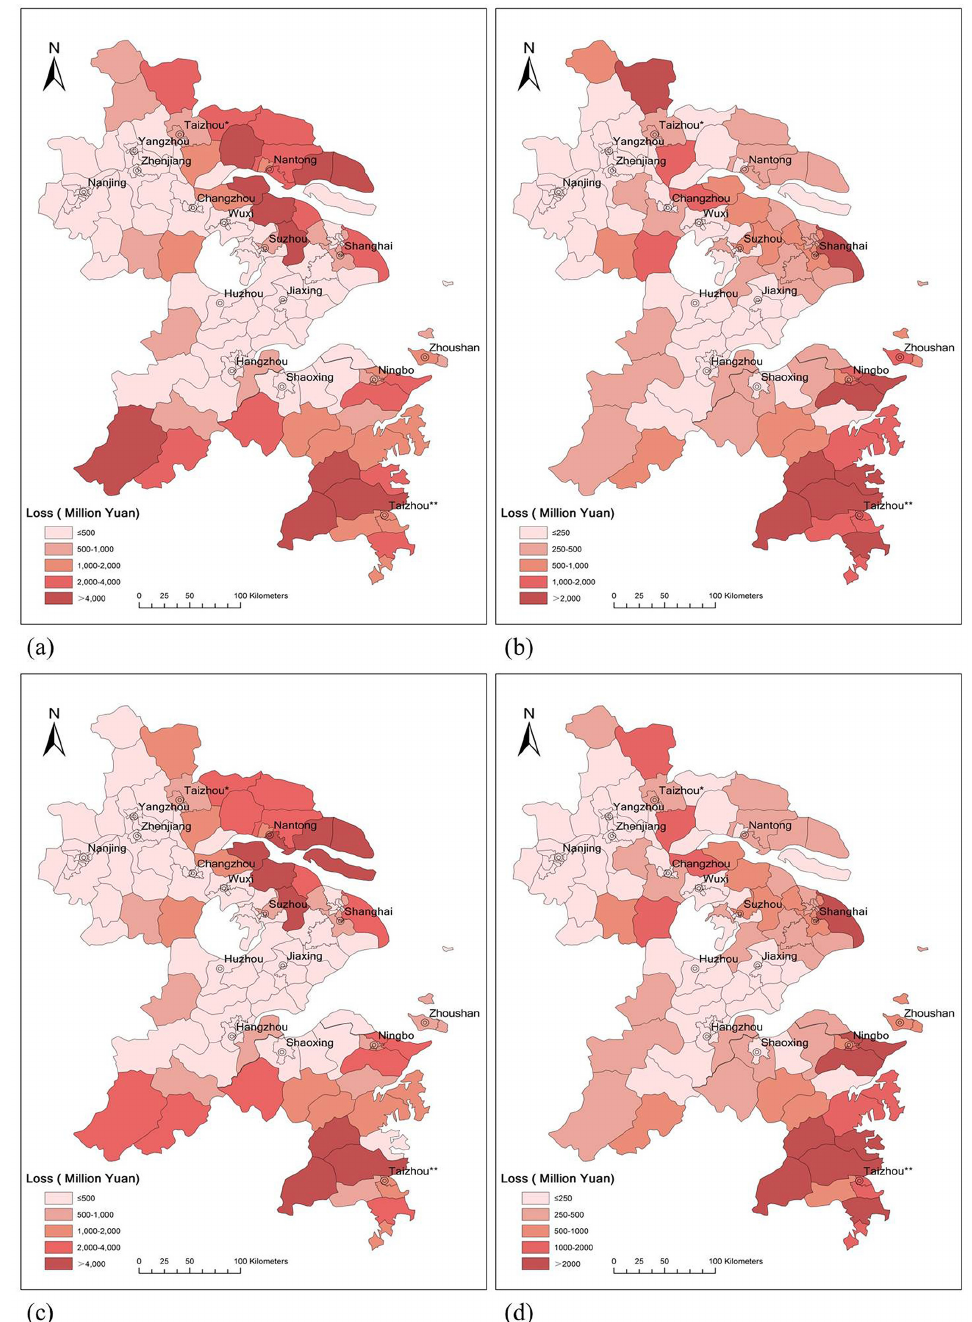
Figure 7. Loss distribution influenced by two consecutive typhoons with different exceedance probabilities. (a) Loss distribution influenced by two typhoons with exceedance probability of 1% and exceedance probability of 10%. (b) Loss distribution influenced by two typhoons with exceedance probability of 5% and exceedance probability of 10% (c) Loss distribution influenced by two typhoons with exceedance probability of 10% and exceedance probability of 1%. (d) Loss distribution influenced by two typhoons with exceedance probability of 10% and exceedance probability of